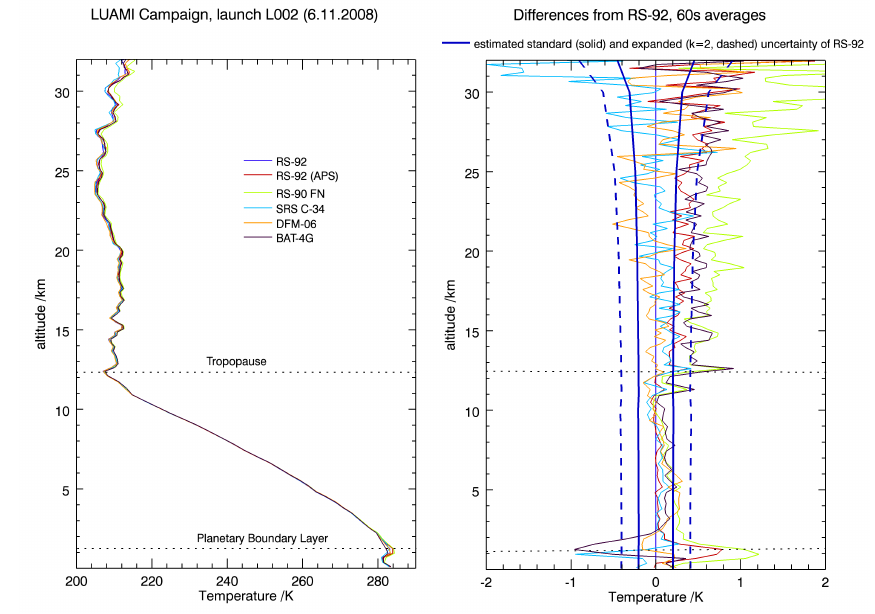
Fig. 6. Temperature profiles from radiosondes (left) launch with one balloon (L002) on 5 November 2008 at 10:45UT during the Lindenberg Upper-Air Method Intercomparison campaign (LUAMI). The right panel shows the differences with respect to the Vaisala RS92. The thick blue lines show the estimated standard (solid) and expanded (k=2, dashed) uncertainty of the Vaisala RS92 temperature measurements.